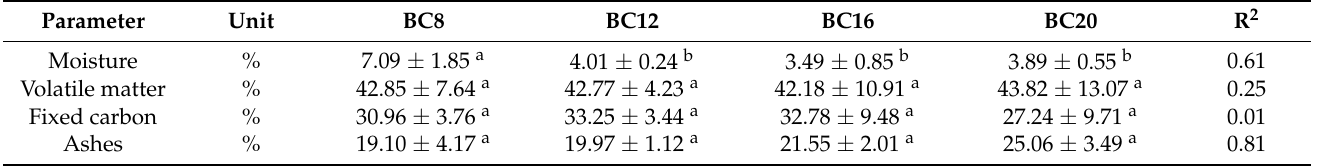
Table 2. Airflow effect on wild sugarcane biochar proximate